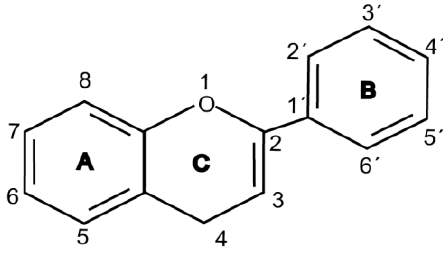
Figure 3. Basic structure of flavonoid.